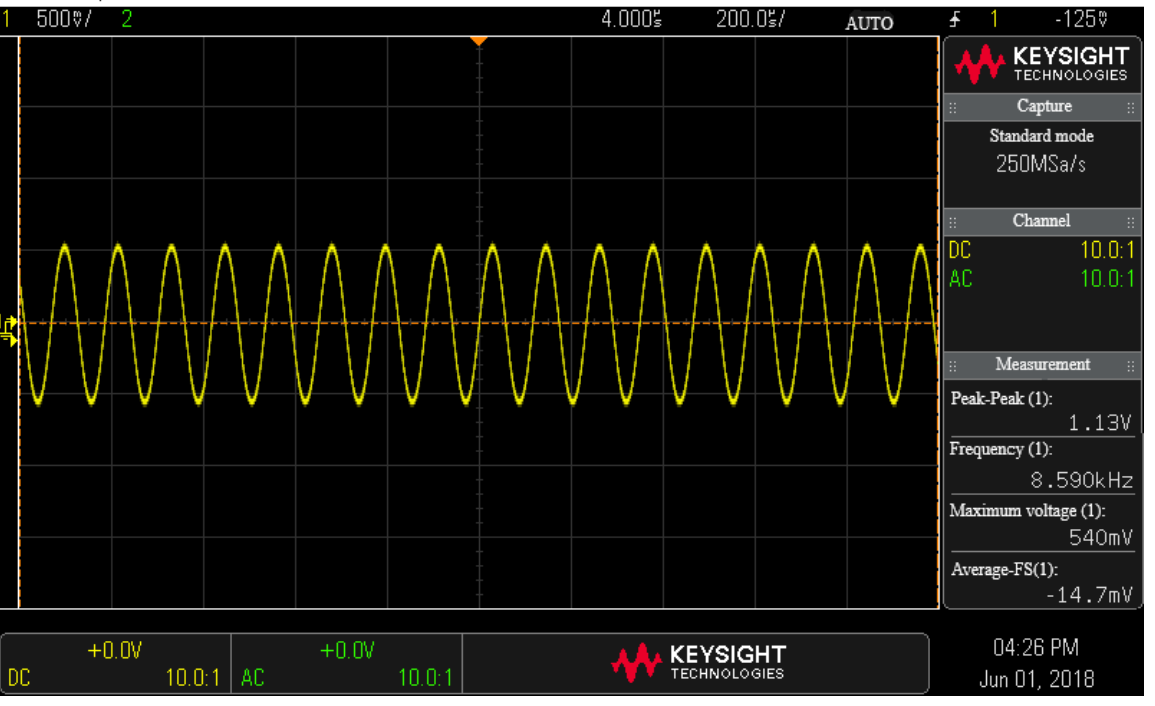
Figure 14. Time domain test chart for driving signal.